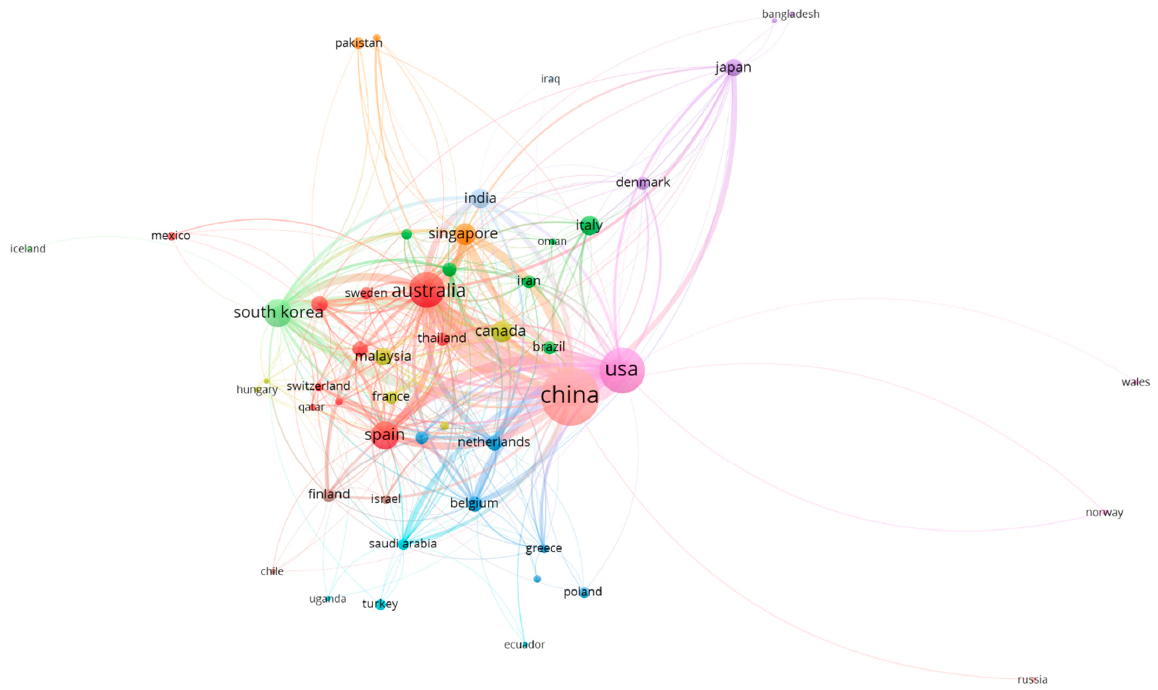
Figure 5. A map of the most cited countries based on the number of documents.